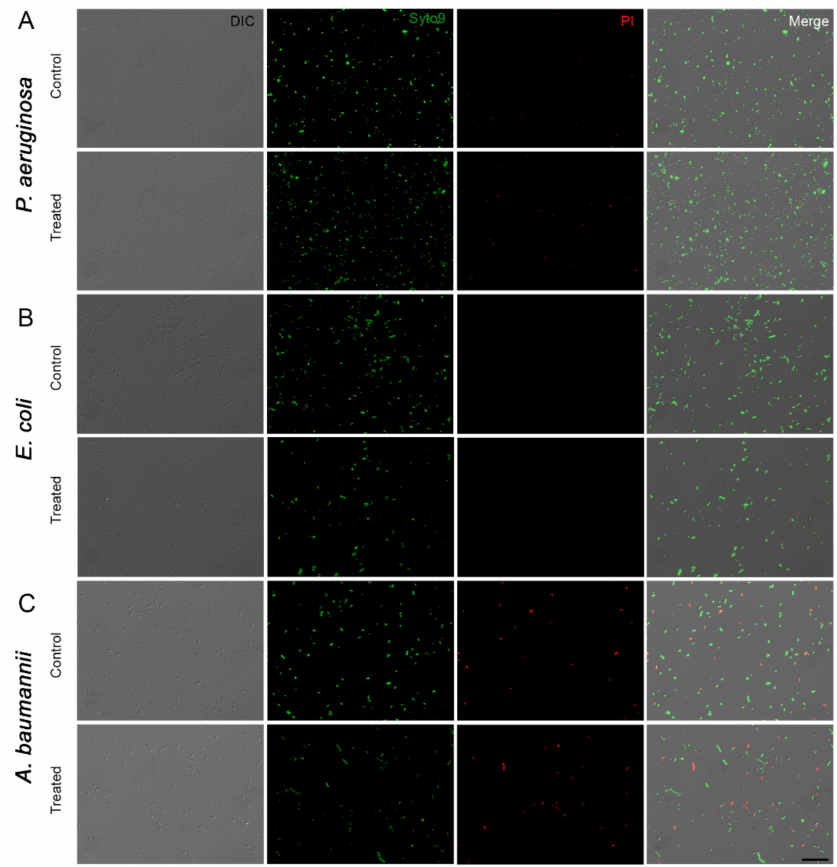
Figure 4. Fluorescence images of P. aeruginosa ( A ), E. coli ( B ), and A. baumannii ( C ) were exposed to O 3 for 10 h and stained with Syto9 (green) and propidium iodide (PI; red). Live bacteria were evidenced using Syto9, while membrane-permeable dead bacteria were stained with PI DI.C: differential interference contrast. Bar = 20 µ